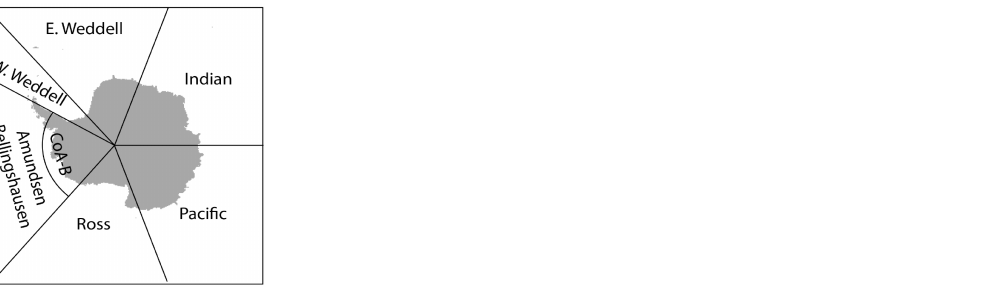
Figure 8. Geographical location of the different sectors. The figure is extracted from Kacimi and Kwok [54].